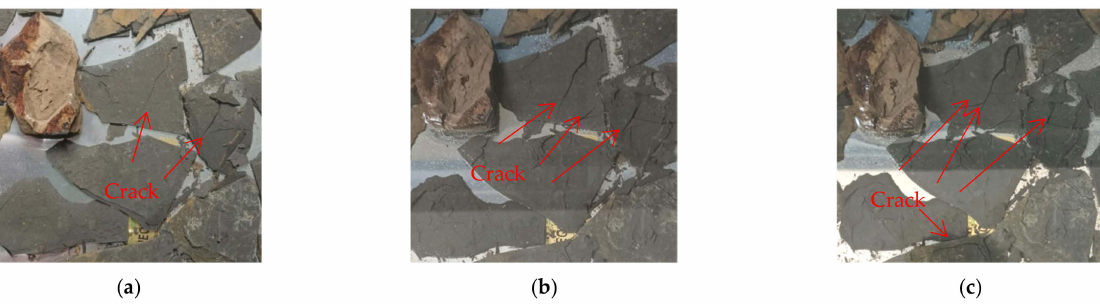
Figure 5. Carbonaceous shale disintegration after initial water immersion: ( a ) immersed in water for 15 min; ( b ) immersed in water for 1 h; ( c ) immersed in water for 3